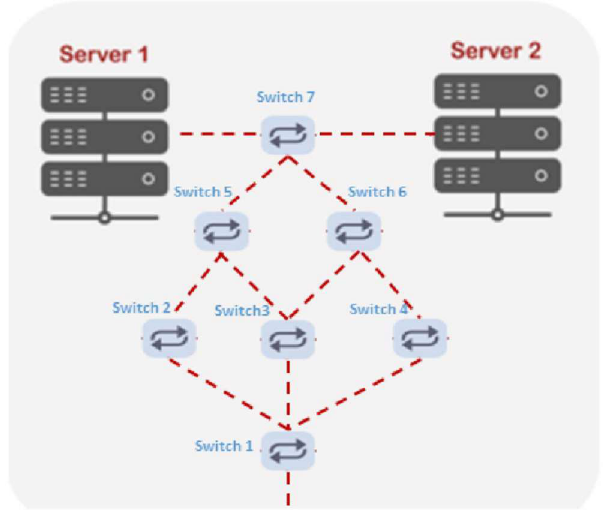
Figure 3. Topology No. 1 of Network.